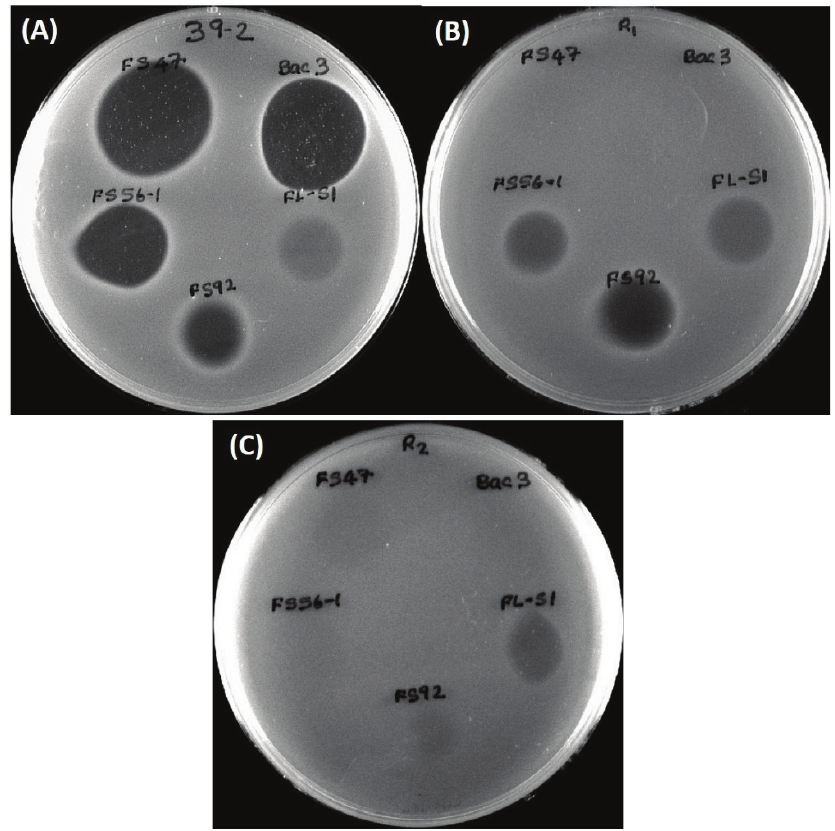
Figure 3. ( A ) L. monocytogenes 39-2 (R0) spotted with cell free supernatants from five Bac + strains: Lb. curvatus FS47, P. acidilactici Bac3, Lactococcus lactis FLS1, En. thailandicus FS92, En. faecium FS56-1; ( B ) L. monocytogenes 39-2 (R1) spotted with the same five Bac